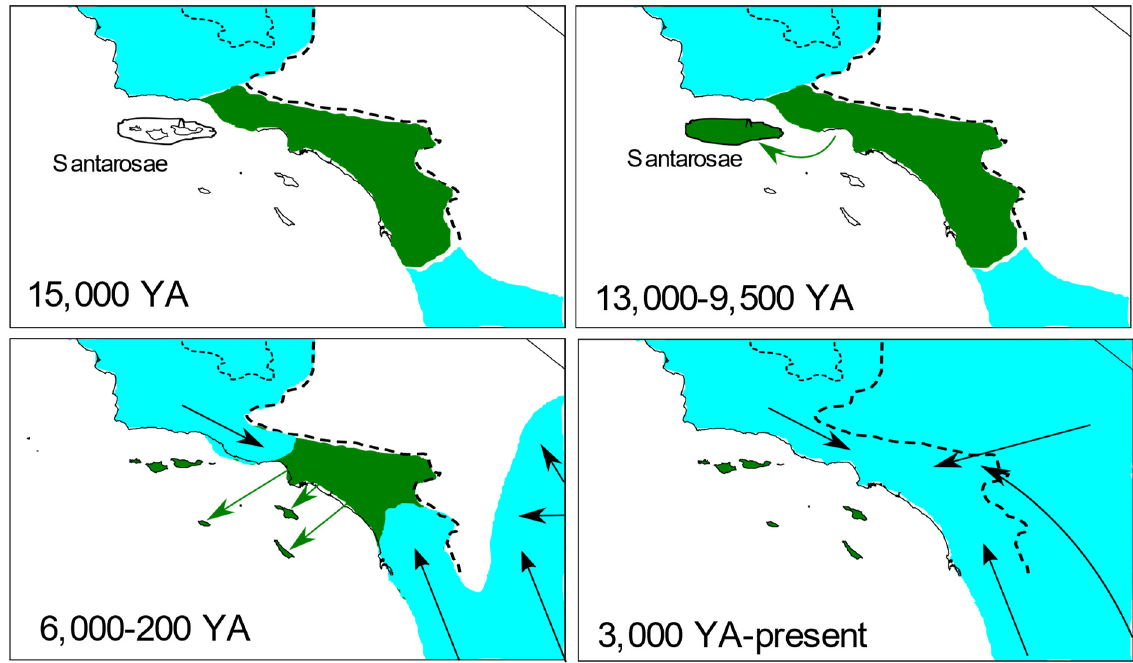
Figure 6. Schematic representation of a hypothesis explaining the origins of island foxes ( Urocyon littoralis ) from a mainland ancestor replaced by expanding populations of gray foxes ( U. cinereoargenteus ). Island foxes and their immediate mainland ancestors (green) are distinguished from gray foxes (blue) 15,000 years ago (YA), prior to their introduction to the northern super-island, Santarosae 13,000–9500 YA, followed by their independent introductions to each of the southern islands 6000–200 YA, and finally their extirpation and replacement by expanding gray foxes on the mainland during the late Holocene. Overlapping time intervals reflect uncertainty in timing of extirpation and replacement. Putative introductions of foxes to the Channel Islands are indicated by green arrows and putative expansion routes of gray foxes are indicated by black arrows. Dashed lines indicate boundary to the California Floristic Province and dotted line bounds the Central Valley.